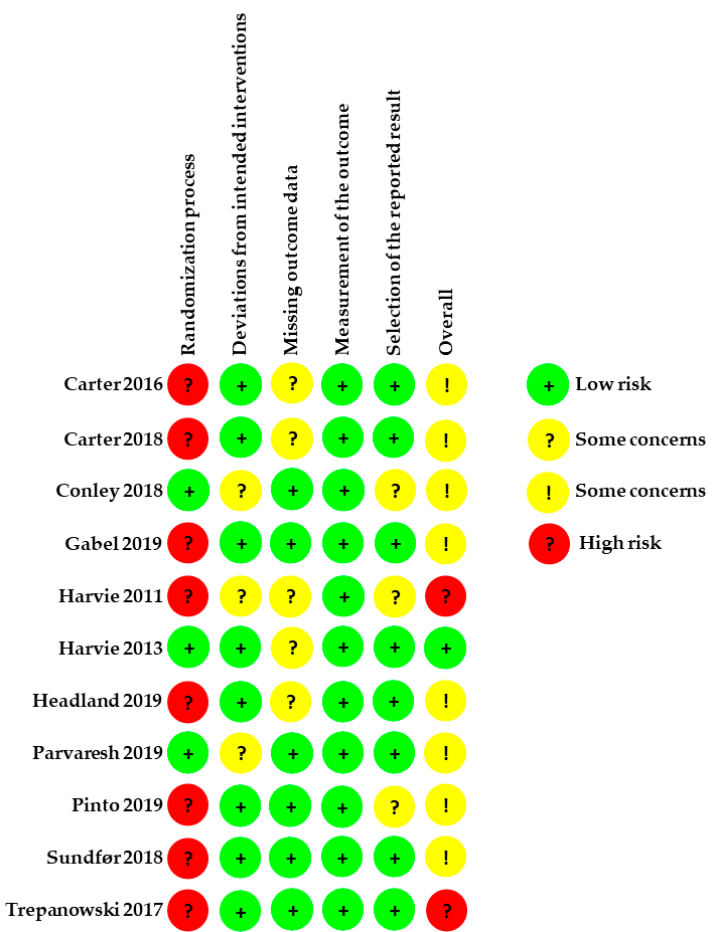
Figure 8. Risk of bias summary. Judgments about each risk of bias item for each included study .